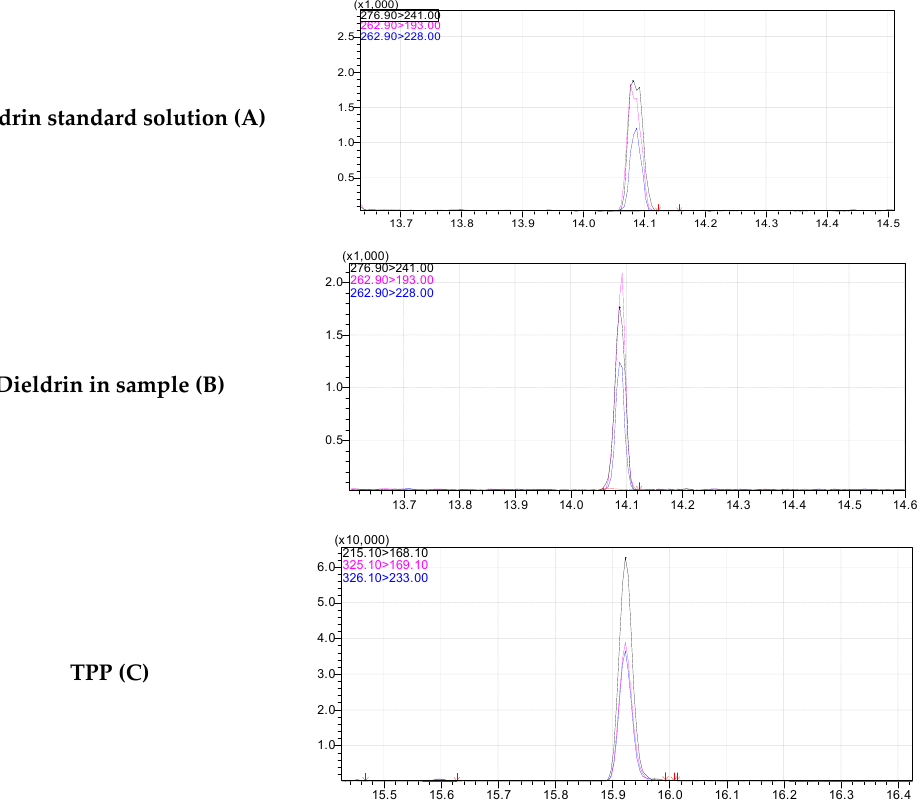
Figure 1. MRM chromatograms of dieldrin standard solution at 0.005 mg L − 1 ( A ), dieldrin in positive sample ( B ), and TPP internal standard solution at 0.02 mg L − 1 ( C ).